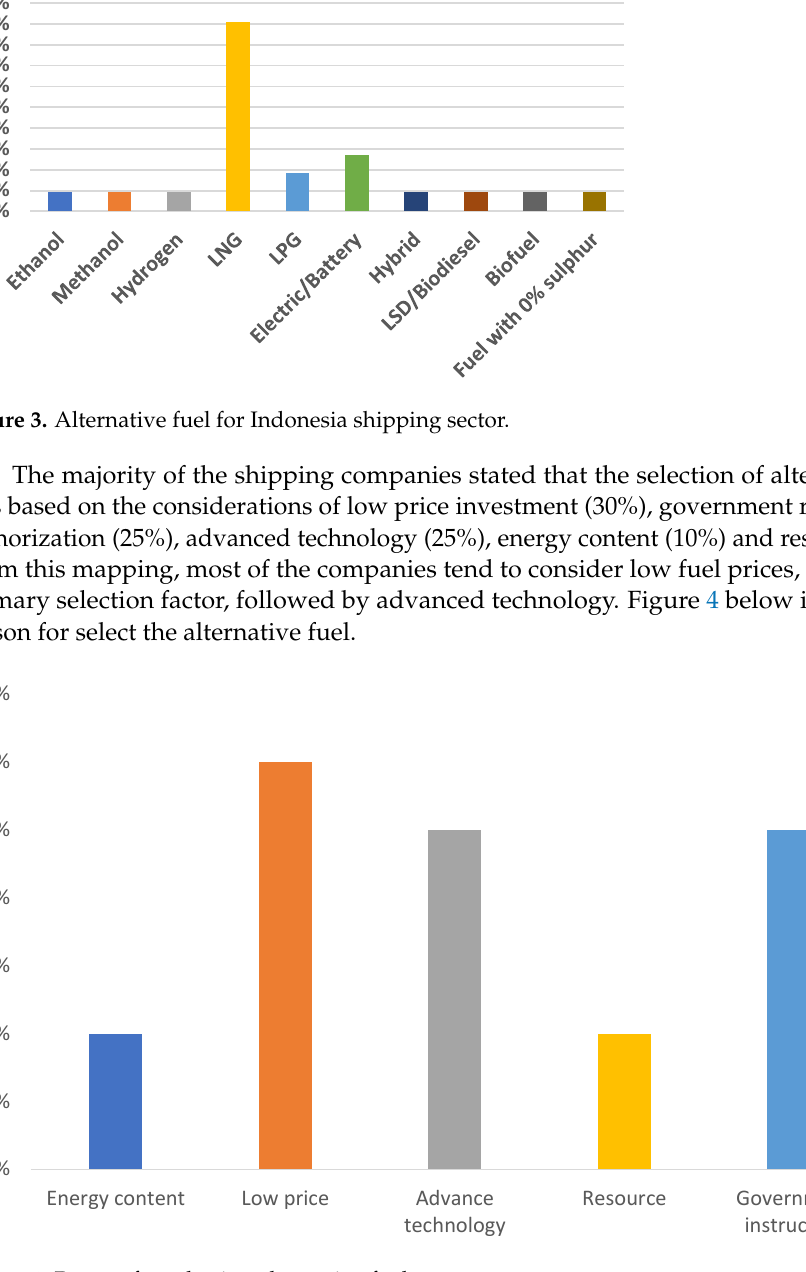
Figure 4. Reason for selecting alternative fuel.